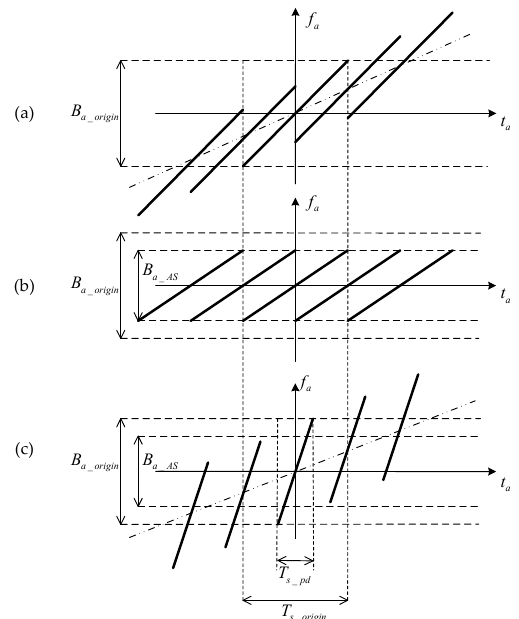
Figure 11. Azimuth time-frequency relationships corresponding to Equations (17), (22), and (24) are illustrated in ( a ), ( b ), and ( c ), respectively.